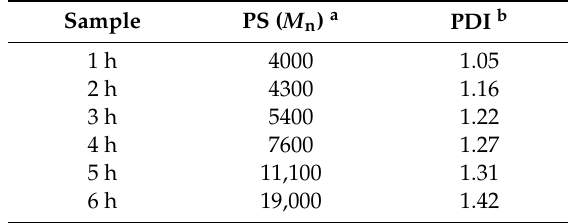
Table 1. Molecular weights of PS- b -DDSQ- b -PS polymers used in this study.